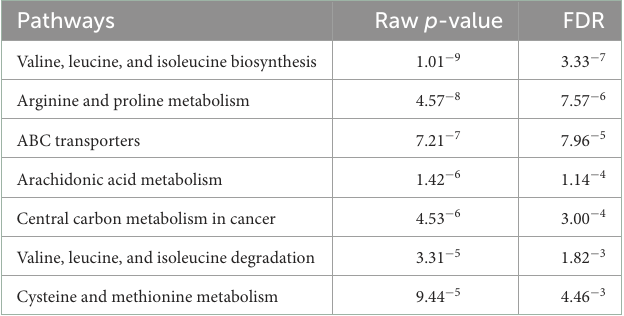
TABLE 2 Statistically significant metabolic pathways from joint multi-omics